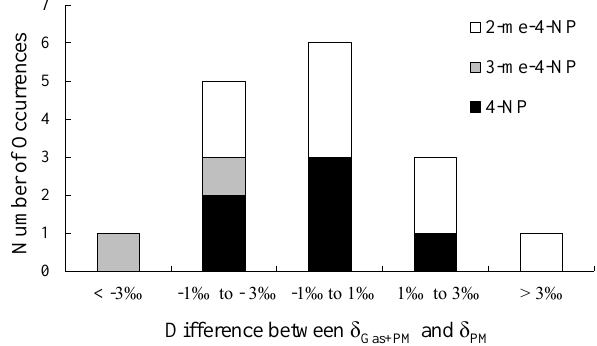
Figure 6. Frequency distribution for the difference in the stable car- bon isotope ratio of target nitrophenols in the gas phase + PM and in PM for samples collected in